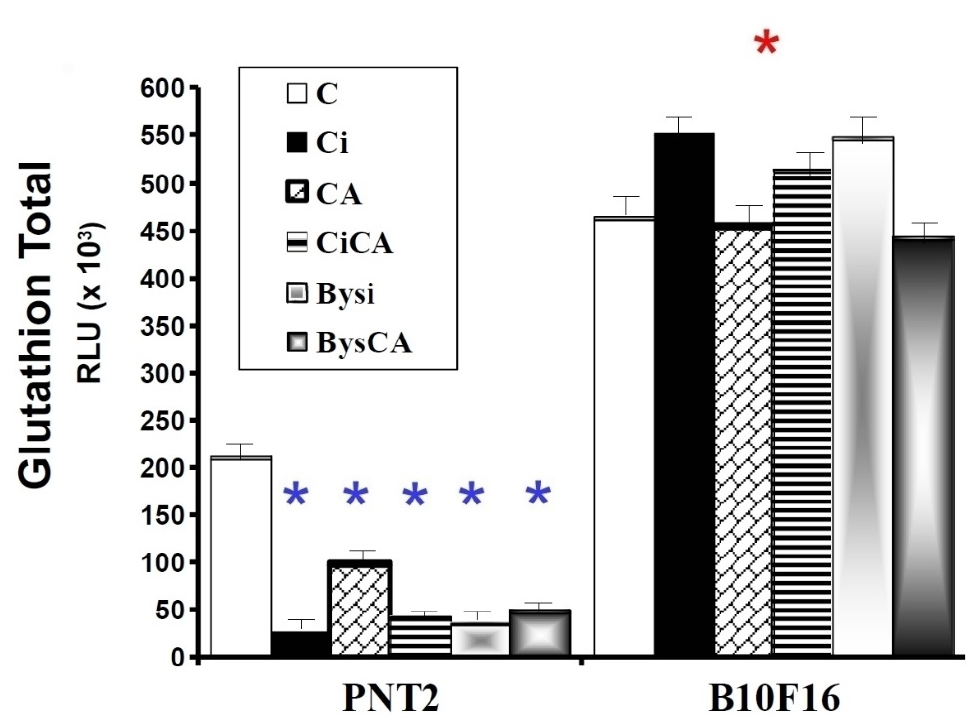
Figure 9. GSH assay: total glutathione concentrations of the different groups studied (C, control; CA, treated with carnosic acid; Ci, irradiated control; CiCA, irradiated previously treated with carnosic acid; Bysi, treated with previously irradiated serum; BysCA, treated with irradiated serum previously treated with carnosic acid) (* p < 0.001 versus PNT2 control (C); * p < 0.001 versus PNT2 control (C)). Data are mean ± SE of six independent experiments.